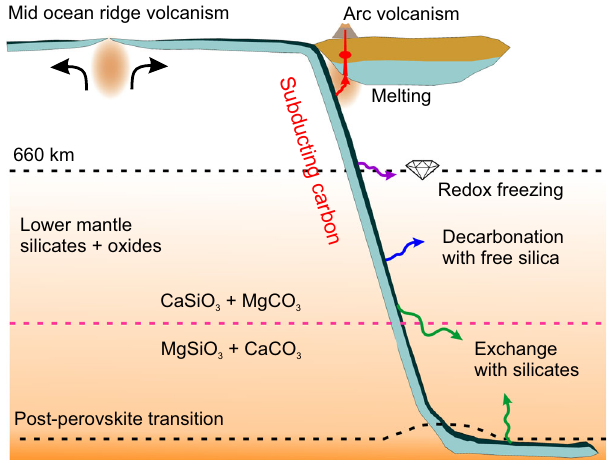
Fig. 4 Schematic illustration of the fate of carbonates in the oceanic crust (dark blue) subducted to the lower mantle. Through subduction, the carbonates may undergo melting (red arrow), redox freezing with metallic iron (purple arrow), decarbonation reaction with free silica (blue arrow), and exchange reaction with lower-mantle silicates (green arrow). Based on the observation of reversal of the carbonate – silicate cation exchange reaction at conditions relevant to cold subducted slabs at mid-lower-mantle depths, CaCO 3 is the potential stable phase that hosts oxidized carbon in the lowermost